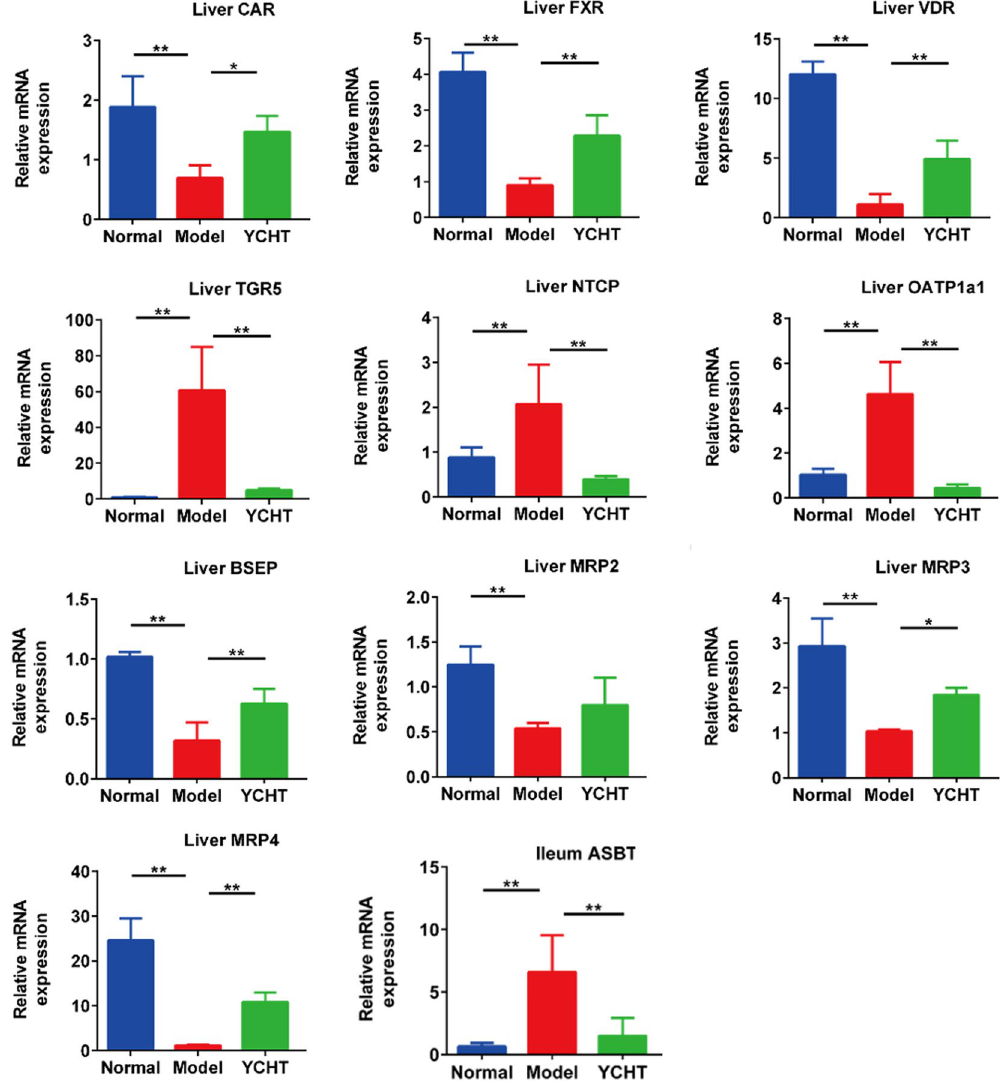
Figure 5. The mRNA expression of liver FXR, CAR, VDR, TGR5, NTCP, BSEP, OATP1a1, MRP2, MRP3, and MRP4, and ileum ASBT. Normal, healthy rats; Model, ANIT treatment for 12 weeks; YCHT, ANIT-induced cholestasis rats treated with Yinchenhaotang from 9 th week to 12 th week. All data are presented as mean ± SEM. (n = 8–12; * P < 0.05; ** P <